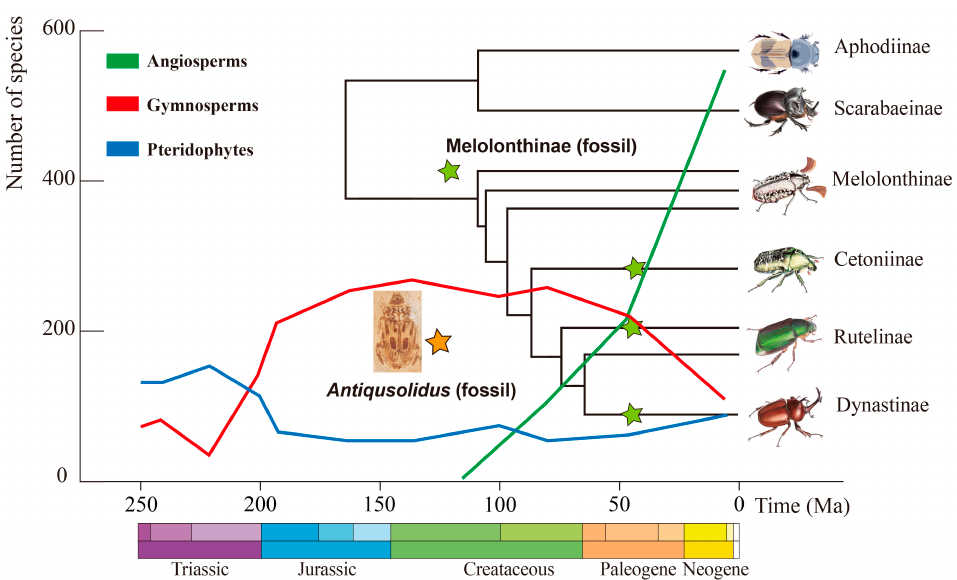
Figure 5. Diagram of the relationships between fossil record of Scarabaeidae and plant diversity in Phanerozoic. The phylogenetic tree and divergence time of some Scarabaeidae lineages were adapted from Ahrens et al. [16]. The three colored curves represent the diversity of plant species (blue line for pteridophytes, red line for gymnosperms, green line for angiosperms) throughout the Phanerozoic (adapted from 80). Stars represent the earliest fossil records in the related group: Antiqusolidus maculatus gen. et sp. n. (orange star, ~125 Ma) and Pelidnotites atavus Cockerell, 1920 (green stars, 48.6–40.4 Ma), for Rutelinae; Cretomelolontha transbaikalica Nikolajev, 1998 (125–112 Ma), for